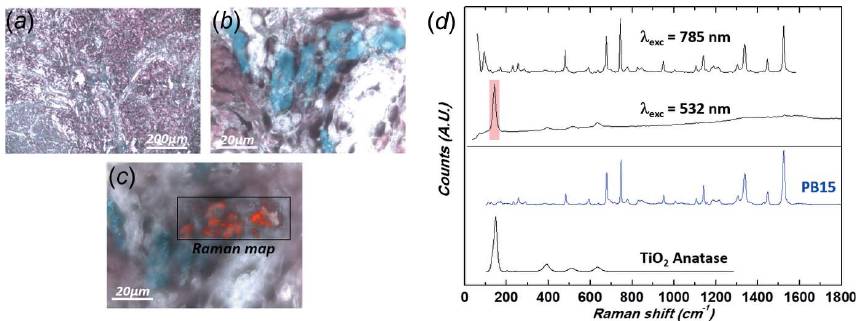
Figure 11 ( a , b ) Optical micrographs of patient 4’s biopsy at two different magnifications [( a ) 10 (cid:4) and ( b ) 100 (cid:4) ] revealing the presence of micrometre-size blue pigments PB15. ( c ) Corresponding Raman spectra collected at the excitation wavelength (cid:4) exc = 785 nm and 532 nm (top and bottom spectra, respectively, objective 100 (cid:4) , numerical aperture = 0.9). The presence of anatase is revealed using a 532 nm Raman probe as shown in the chemical mapping (red pixels, intensity of the 143 cm (cid:2) 1 band) overlapped with the 100 (cid:4) micrograph. Top spectrum is baseline corrected. Reference spectra are also given as comparison: PB15 C.I. 74160, Polycyclic pigment, Phthalocyanine from the Soprano spectral library, anatase (TiO 2 ) downloaded from the RRUFF spectral library (ID R110109, 780